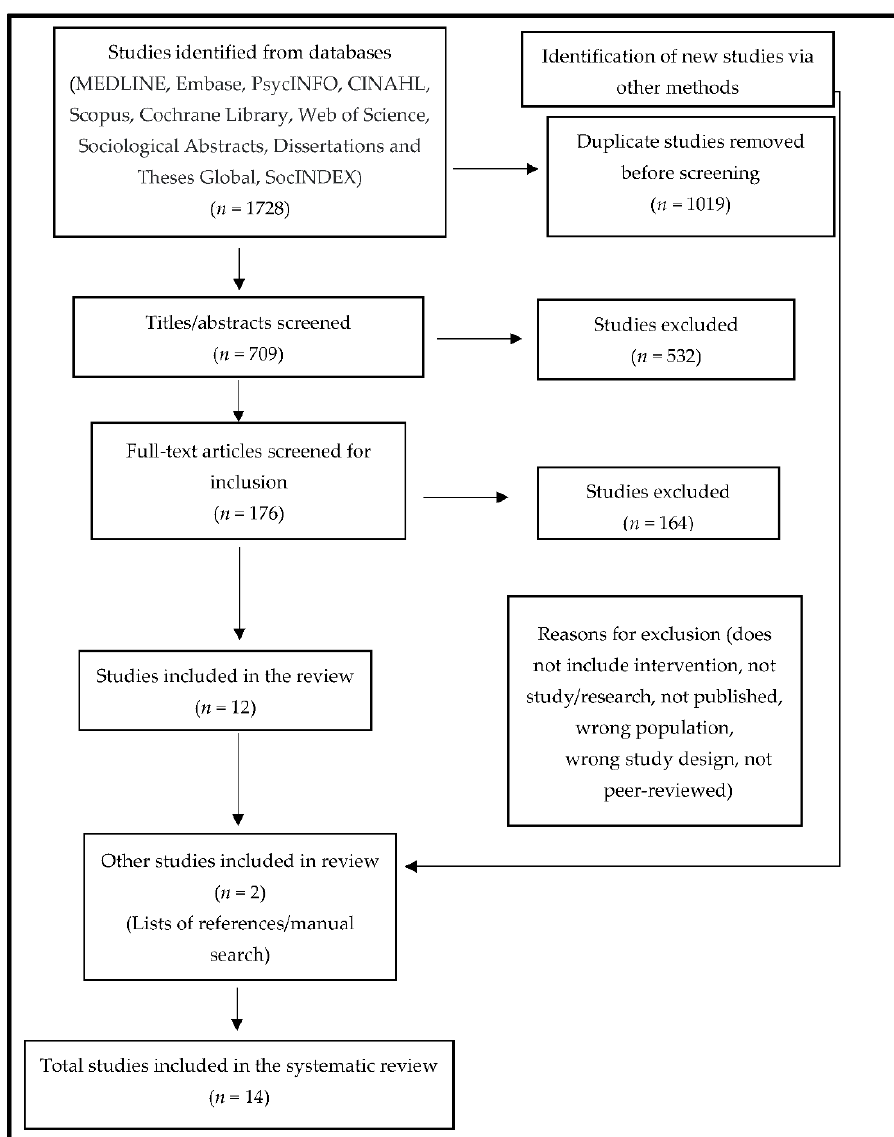
Figure 1. PRISMA flow diagram of the search strategy and included studies. Table 3. Quality Assessment of Included Studies using the Newcastle–Ottawa Scale (each study is allotted the stars (*) for each category (Selection, Comparability and Outcome/Exposure) .